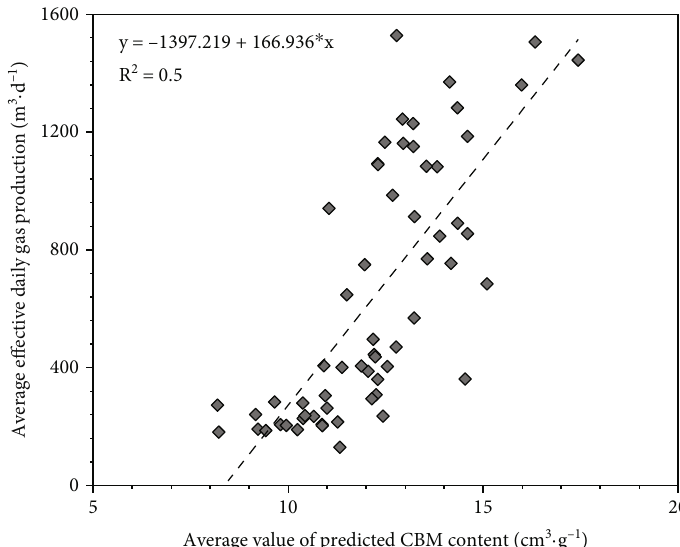
Figure 21: Intersection of CBM content and average e ff ective daily gas